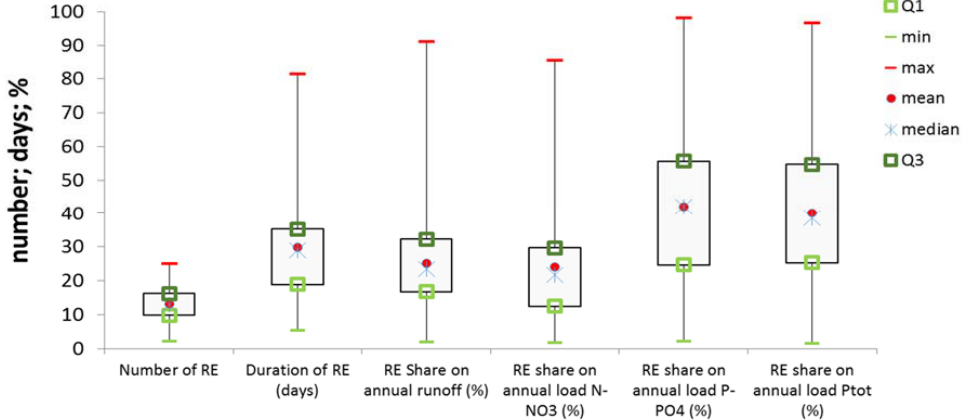
Figure 5. Basic statistics of the share of runoff events (RE) in the annual runoff and nutrient loads (data from all monitored sites and periods).